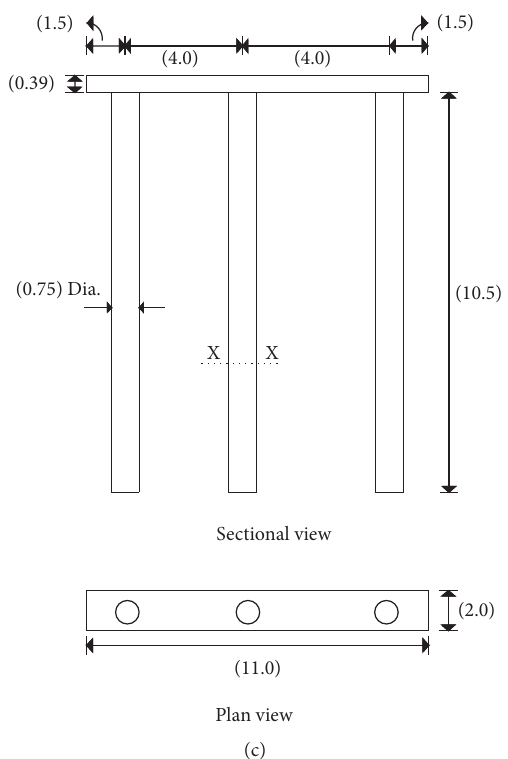
Figure 6: Pile and raft: (a) single pile, (b) pile group-1, and (c) pile group-2.